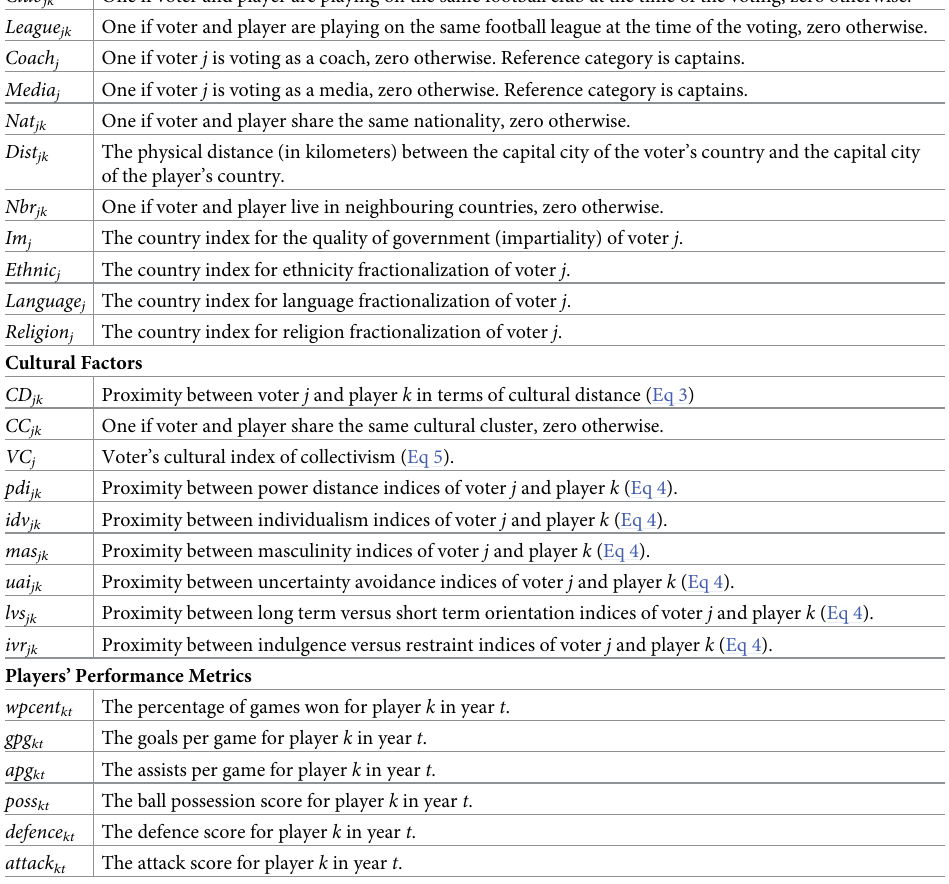
Table 2. In-group and cultural